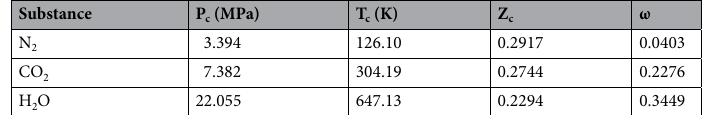
Table 4. Critical properties and acentric factors utilized in the EOSs for the substances used in this paper 79 .